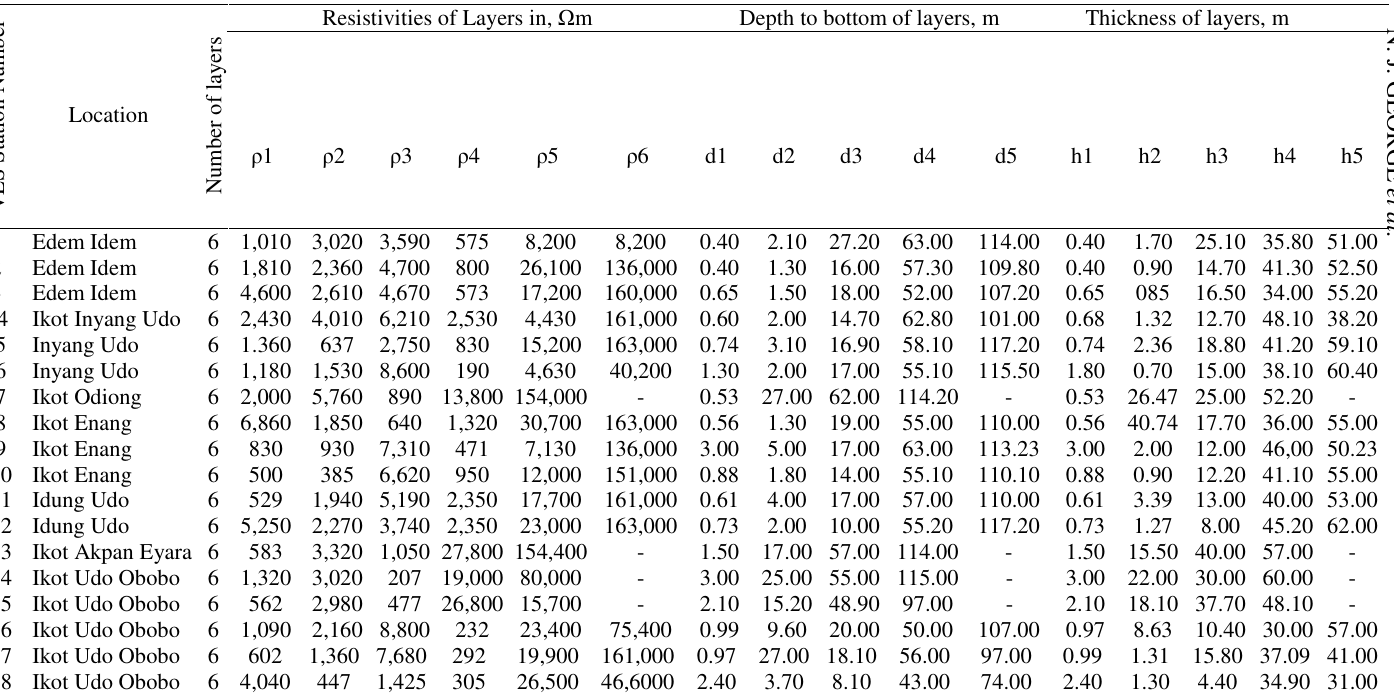
Table 1. Summary of geo-electric survey from computer modeling. Resistivities of Layers in, Ω m Depth to bottom of layers, m Thickness of layers,